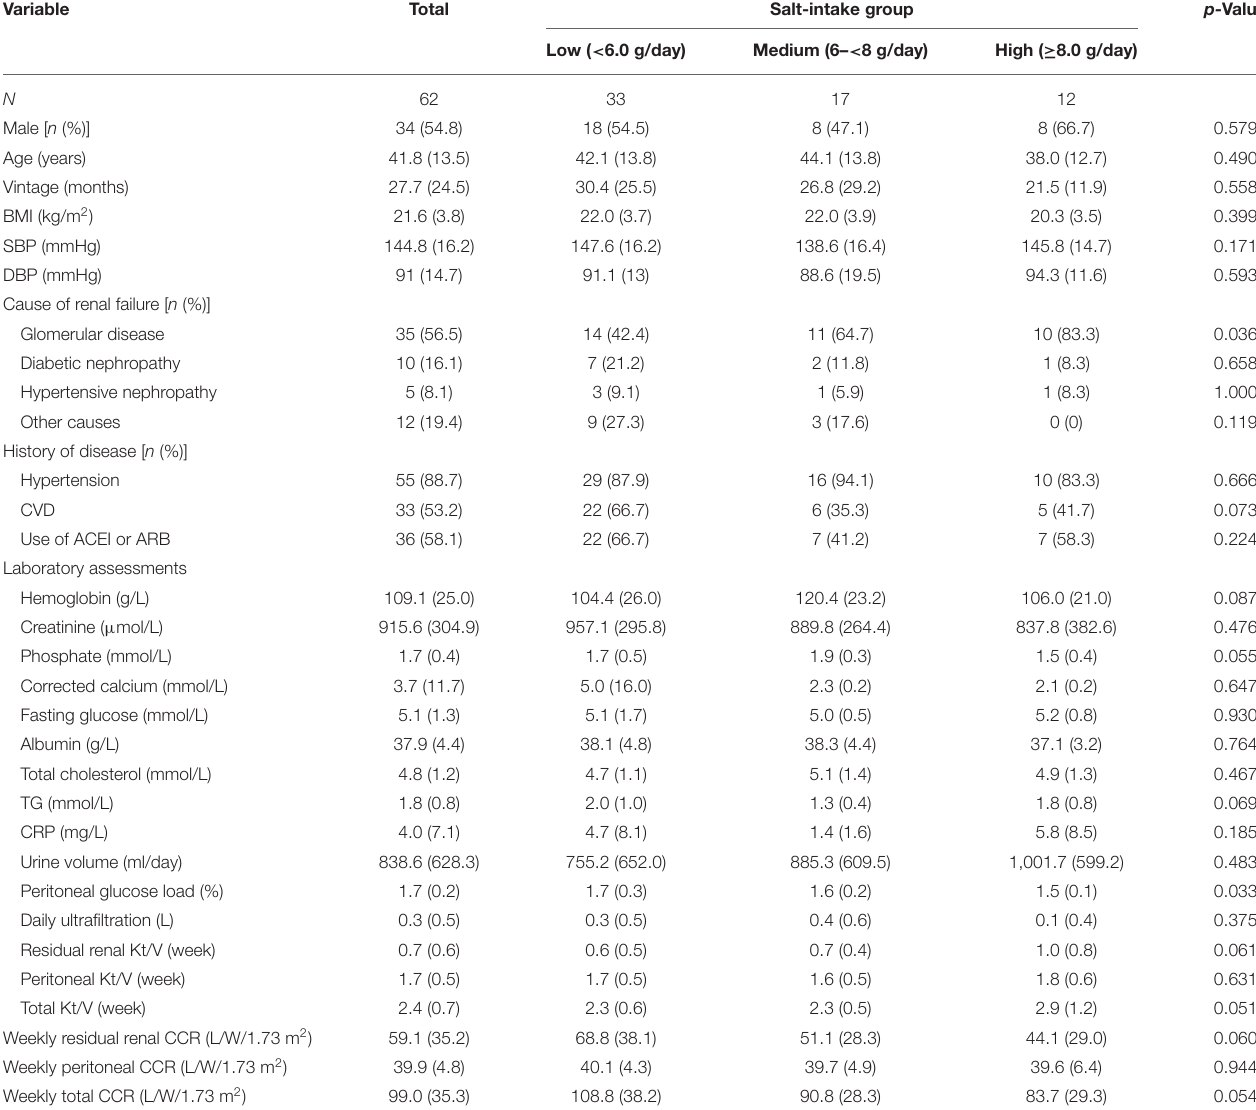
TABLE 1 | Characteristics of peritoneal dialysis patients at baseline.